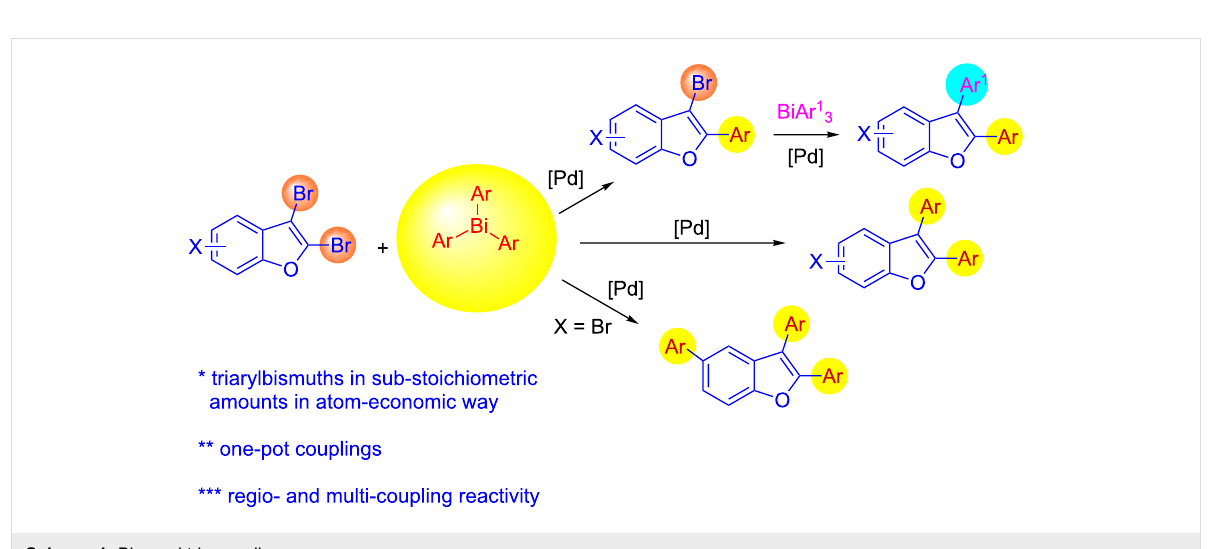
Scheme 1: Bis- and